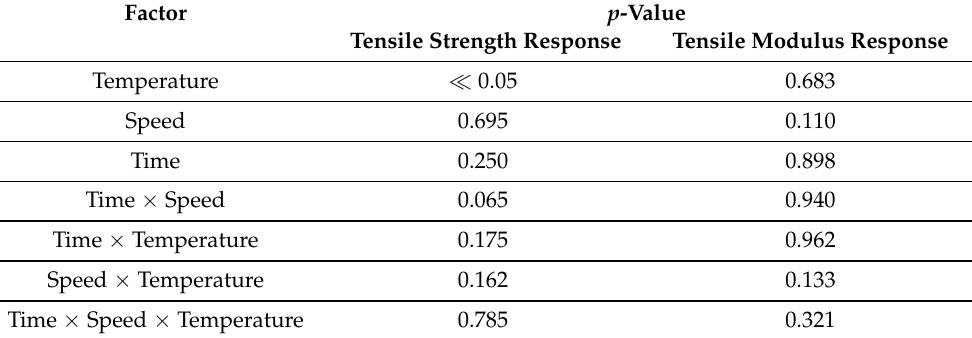
Table 3. p -values for the influence of the compounding parameters on the tensile properties with a significance level of